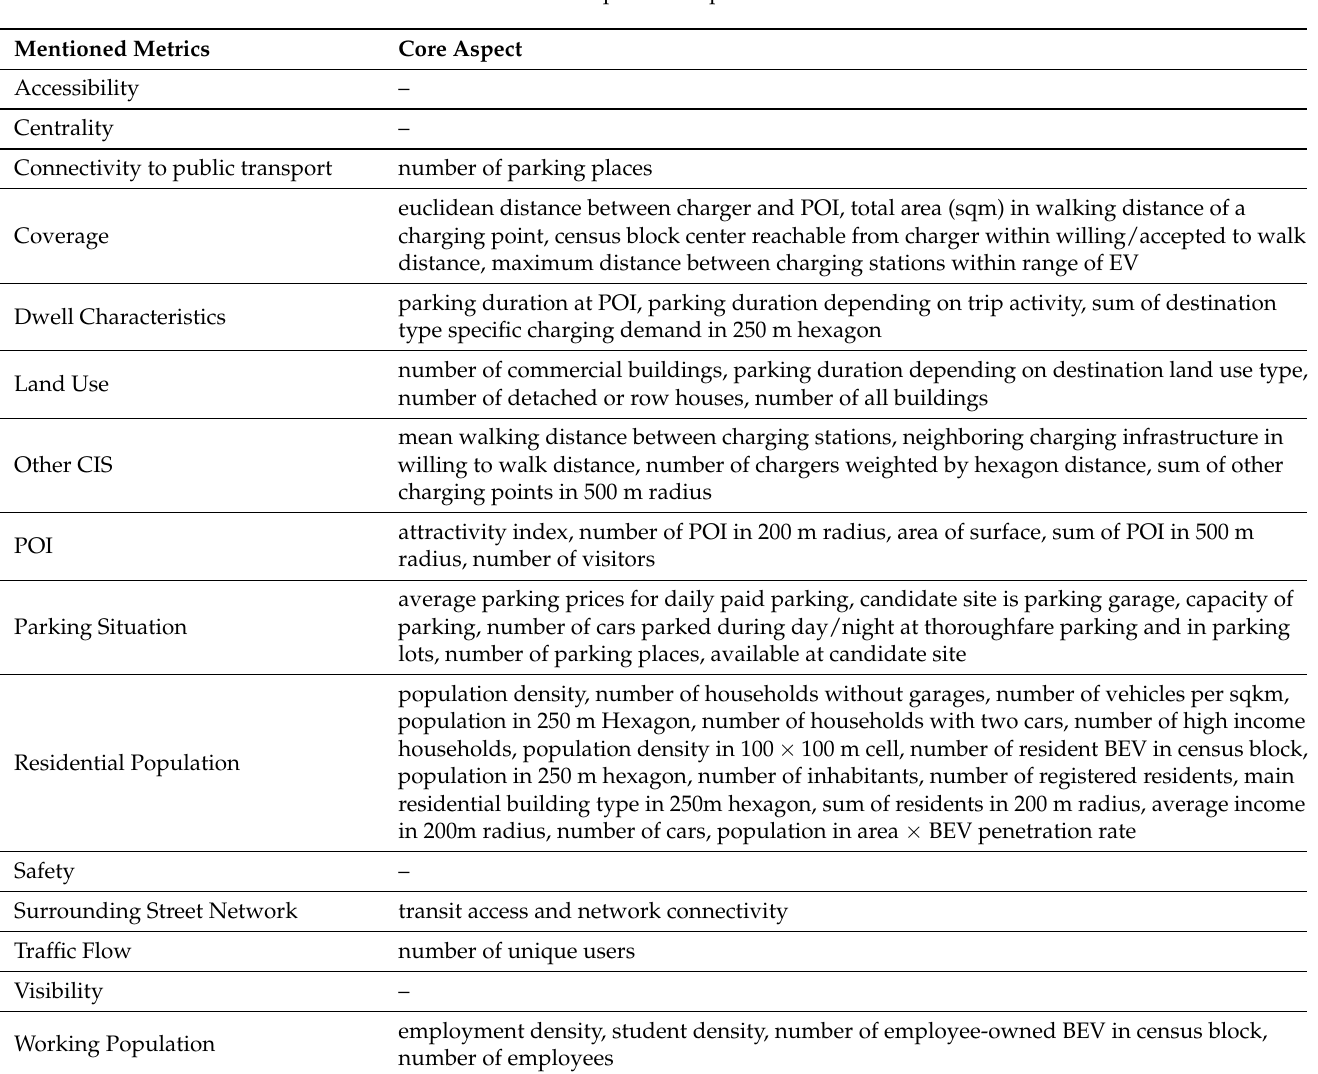
Table 5. Metrics mentioned per core